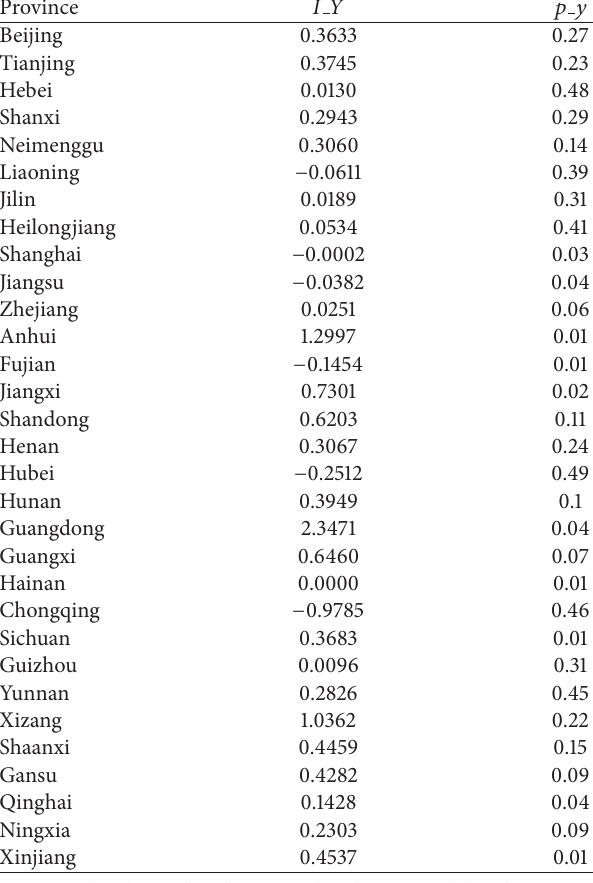
Table 2: Local Moran’s index based on space weight matrix 𝑊 Queen 1 as well as test results.